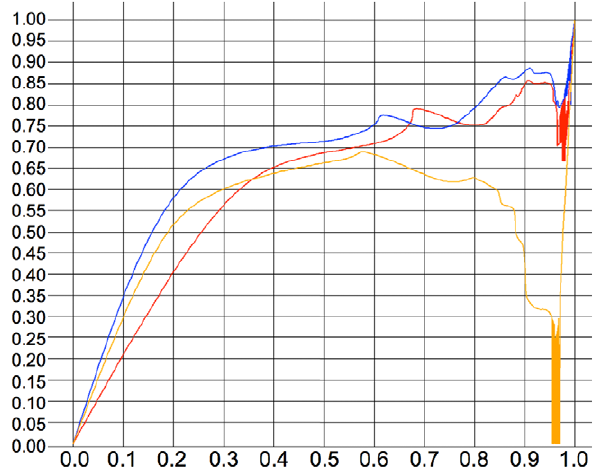
Figure 6. ROC-like curve for MAFIA (blue) applied to ten species, rMonkey (red) applied to six species, and the ‘‘gold standard’’ (gold). Sensitivity is plotted on the y-axis, false-positive rate along the x-axis. Each point corresponds to a different stringency threshold in the processed ChIP-seq data.